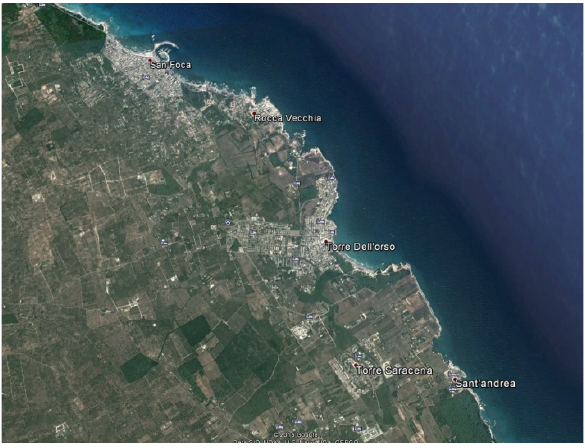
Figure 1. The study area (Google Earth)